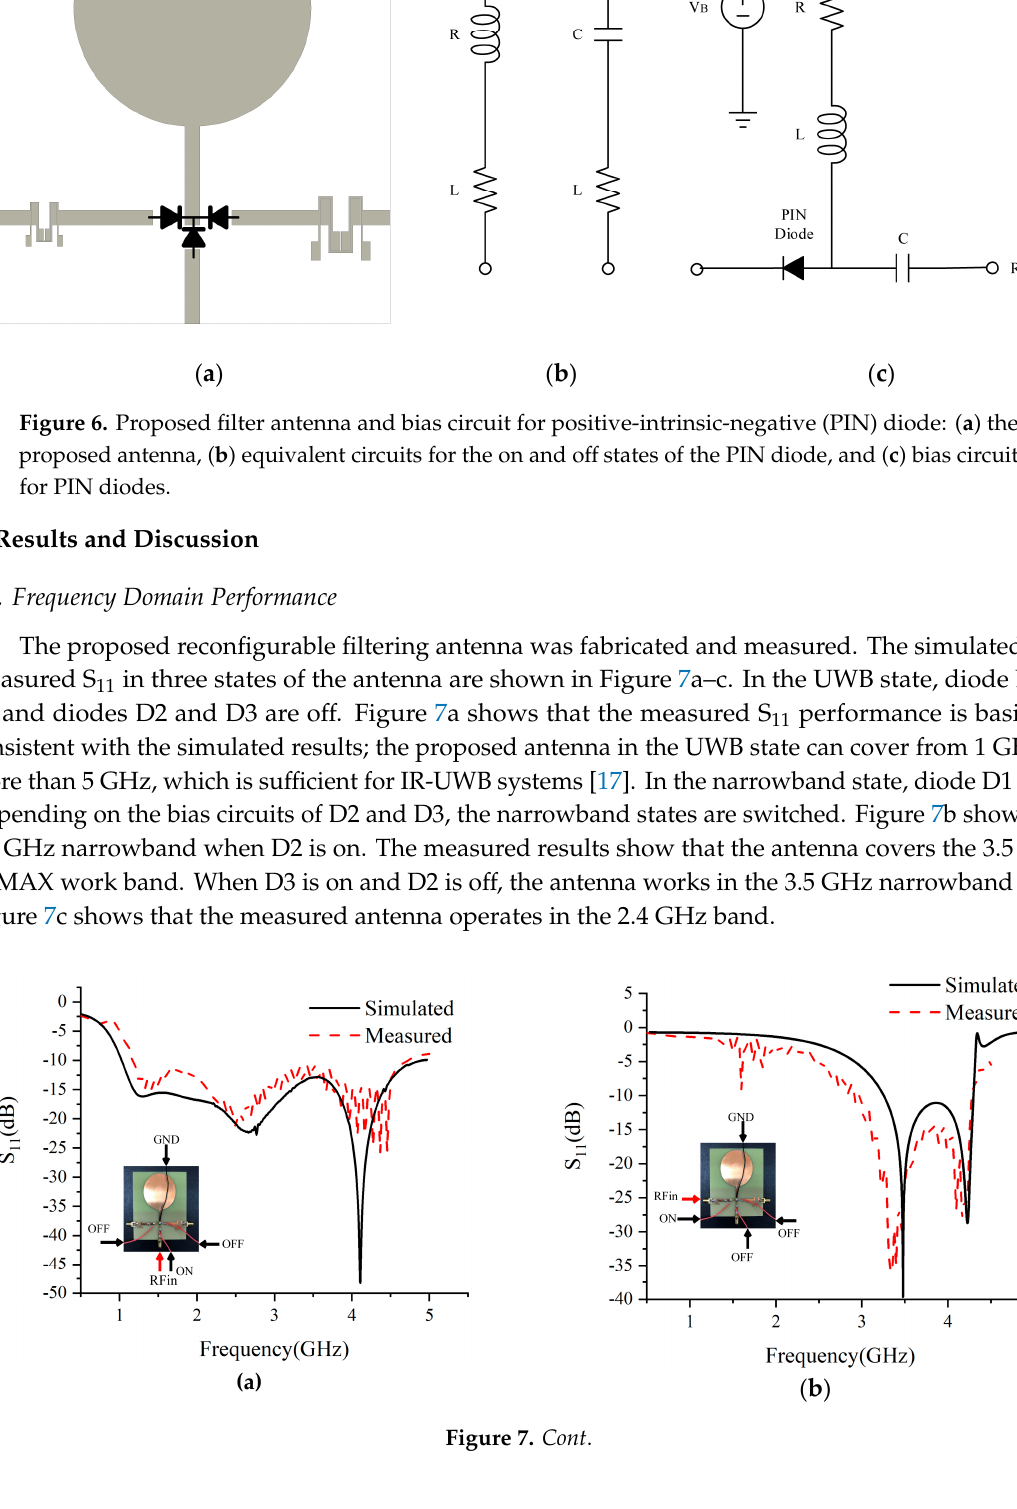
(c) Figure 7. Summary of the S 11 of the reconfigurable antenna: ( a ) UWB state (D1 on, D2 and D3 off); ( b ) 3.5 GHz narrowband (D2 on, D1 and D3 off); and ( c ) 2.4 GHz narrowband (D3 on, D1 and D2 off). As illustrated in Figure 7, the measured and simulated responses were compared. The comparison showed that the measured results of the proposed antenna correspond well in the three states. However, in the wideband state and the 3.5 GHz narrowband state, S 11 shifts at the lower frequency of the whole operating band. Nevertheless, the result is valid and acceptable. Reasonable agreements between the simulated and measured results were obtained. The error is mainly due to the inaccurate modeling of PIN diodes and the fabrication and welding processes. The port isolations of the proposed antenna are displayed in Figures 8a–c. In the three different operating states, high isolation performance (better than 20 dB) was obtained throughout the whole operating frequency band. High isolation indicates that the three states of the proposed antenna can operate dependently. The simulated and measured results in Figure 7 prove this.